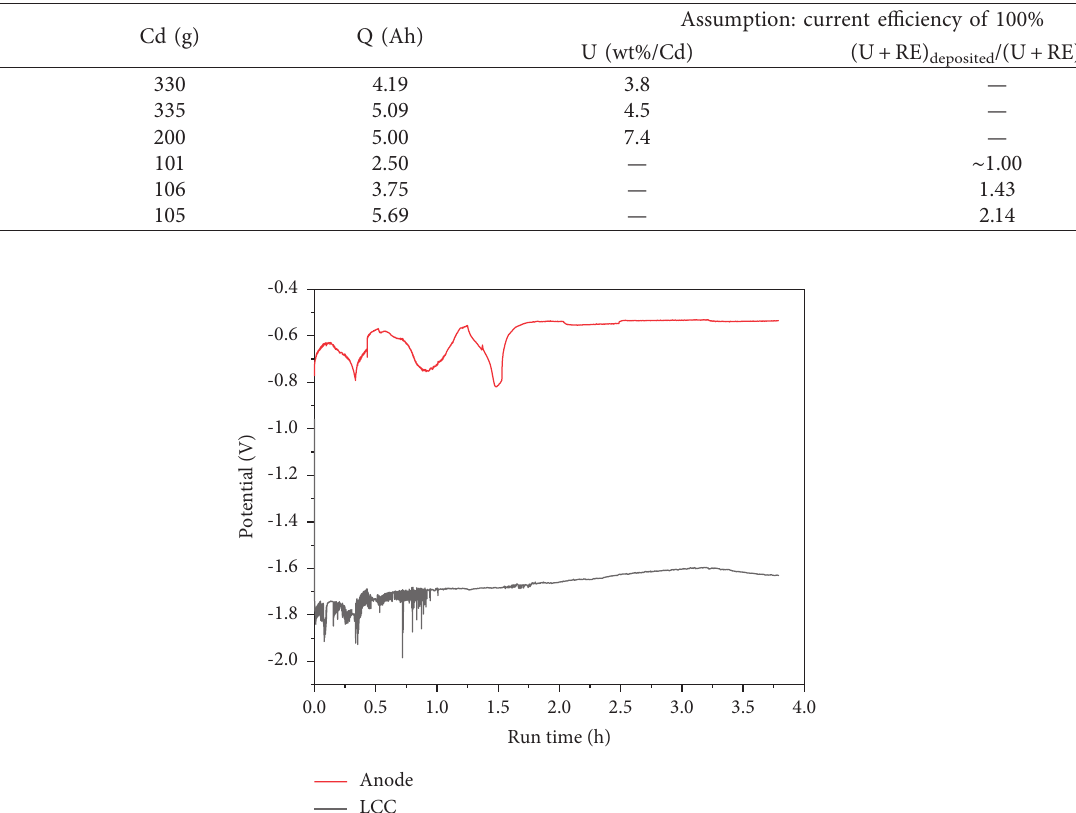
Figure 6: Photographs of the LCC crucible and Cd ingot after run 3. Table 2: Results of electrodeposition runs 1–6 in this study.